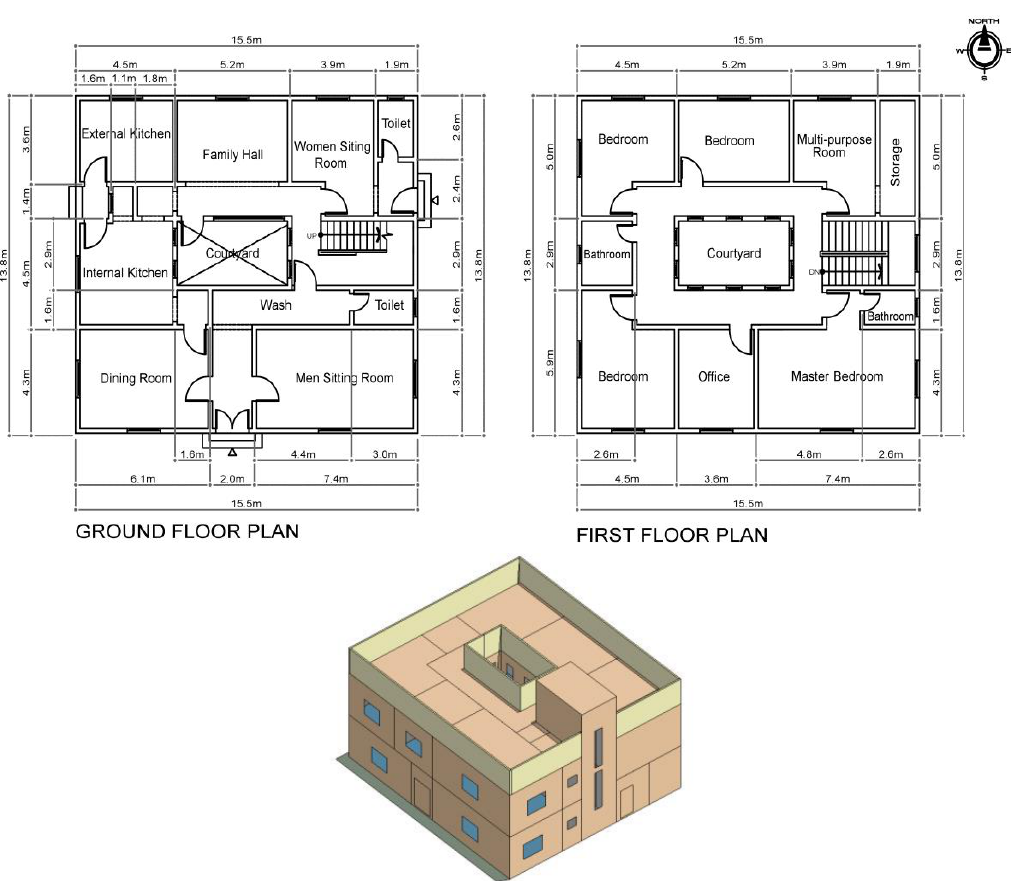
Figure 13. Floor plans and 3D isometric view of the base house after incorporating the courtyard.